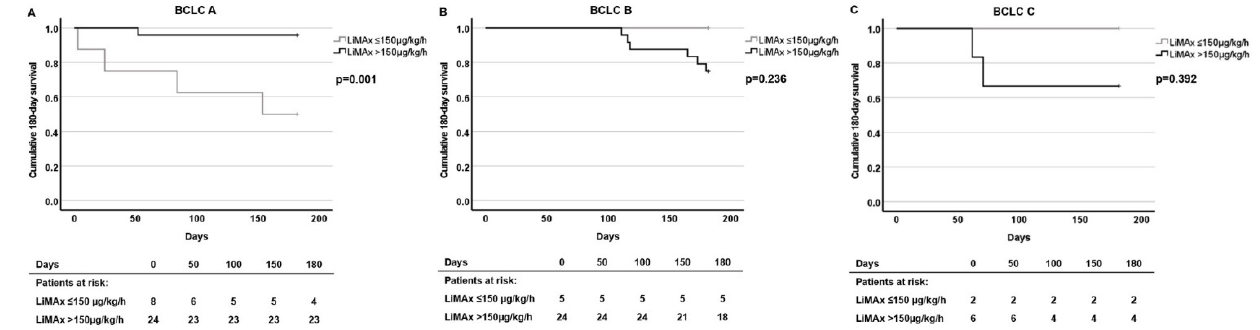
Figure 4. Cumulative 180-day survival in patients with different hepatocellular carcinoma stages according to the LiMAx ≤ 150 μ g/kg/h and LiMAx > 150 μ g/kg/h groups. Patients with ( A ) BCLC A (n = 32), ( B ) BCLC B (n = 29), and ( C ) BCLC C (n = 8) stages. Survival analyses were performed with Kaplan-Meier